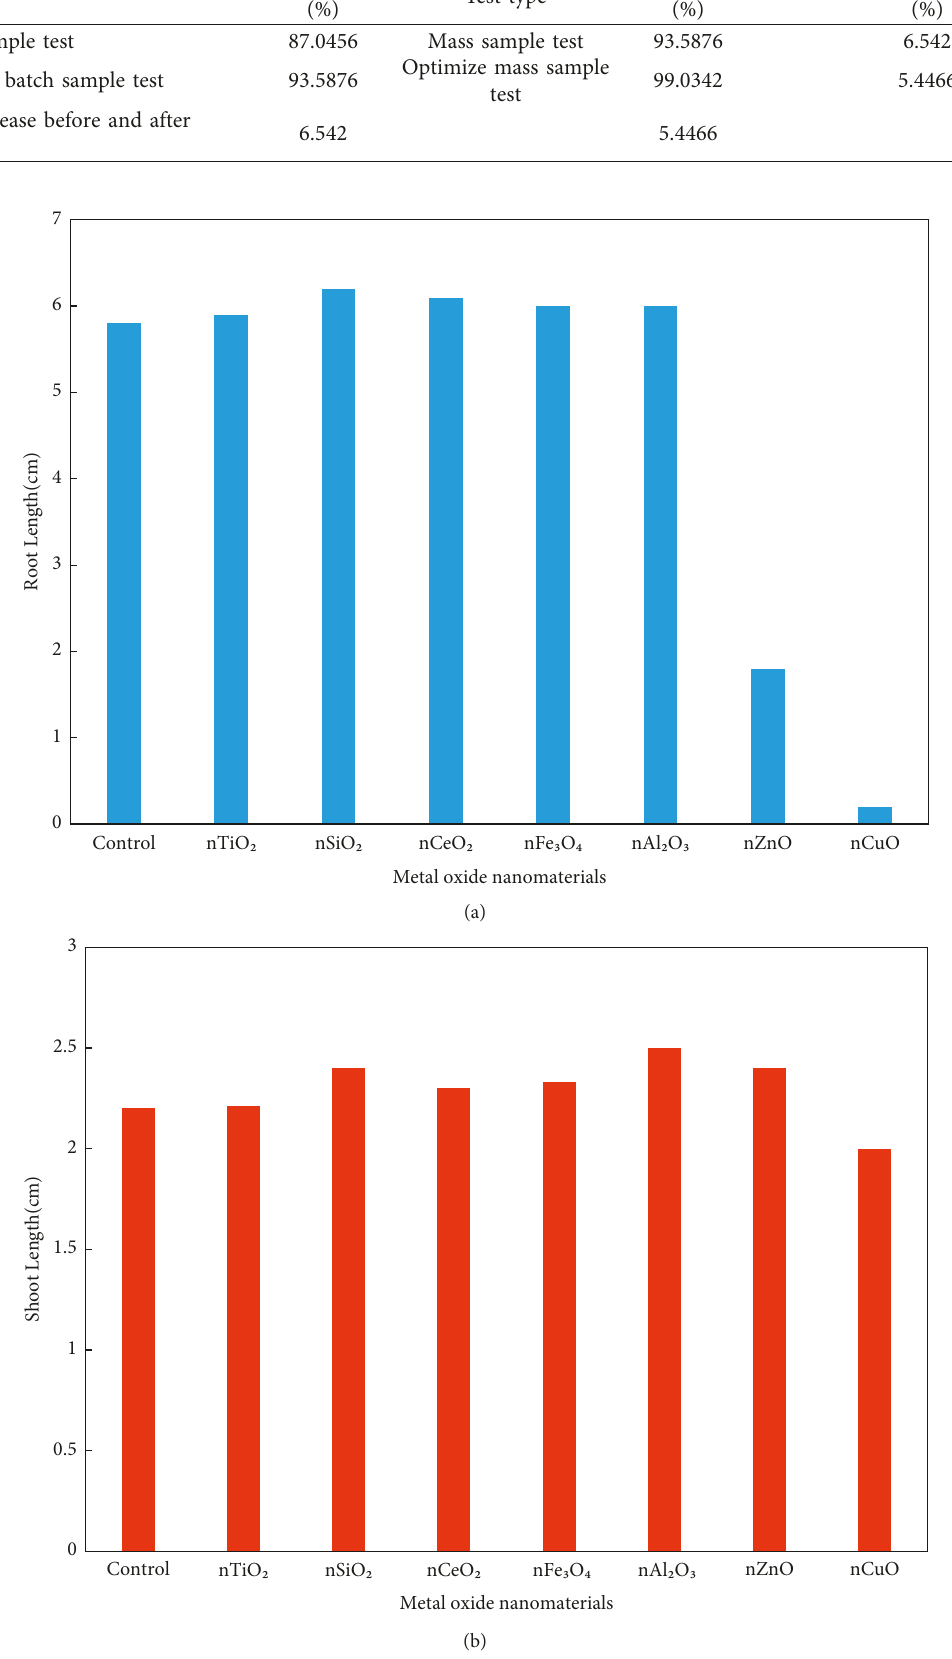
Figure 9: Effects of seven metal oxide nanomaterials on root and shoot growth in rice ((a),